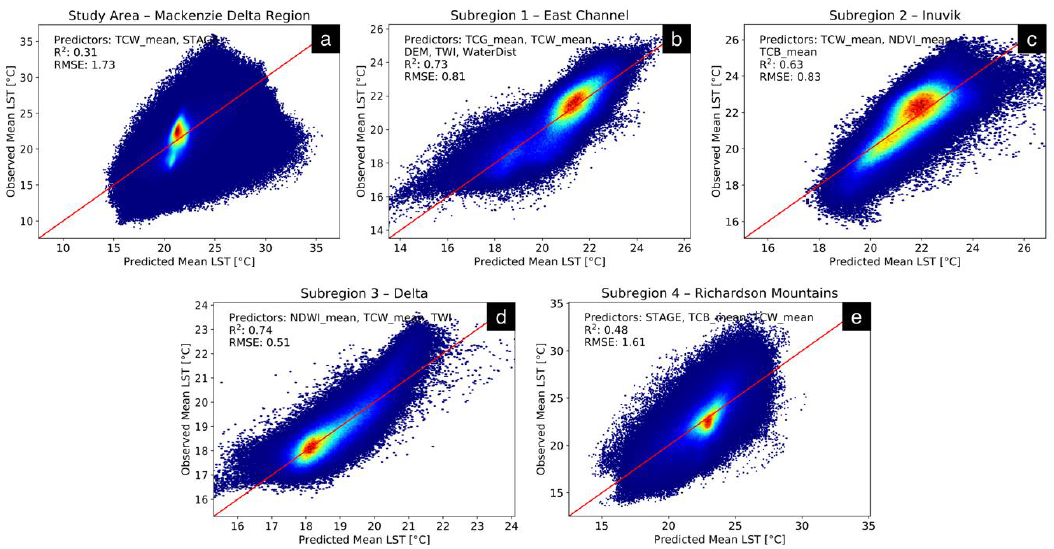
Figure 6. Predicted-observed density plots of the multiple linear regressions for the entire study area ( a ) and the four subregions ( b – e ). Detailed information on each model is provided in Appendix C